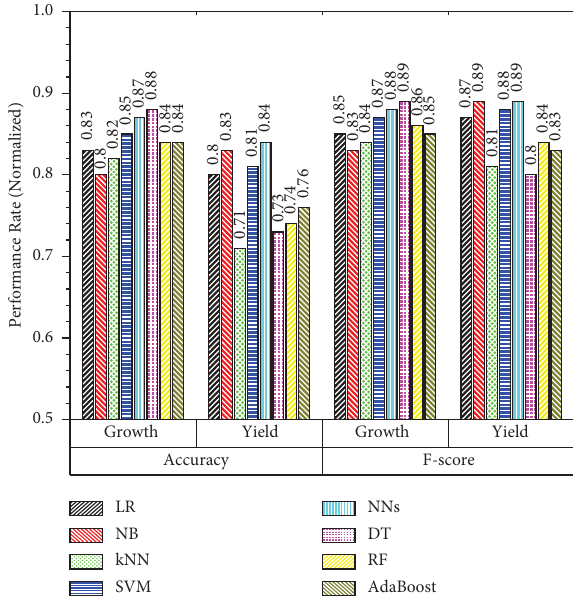
Figure 3: Comparison of the suggested model AdaBoost for classifcation performance in terms of accuracy and the F 1 score of various ML algorithms using growth and yield metrics while taking into account the combined infuence of all water quality